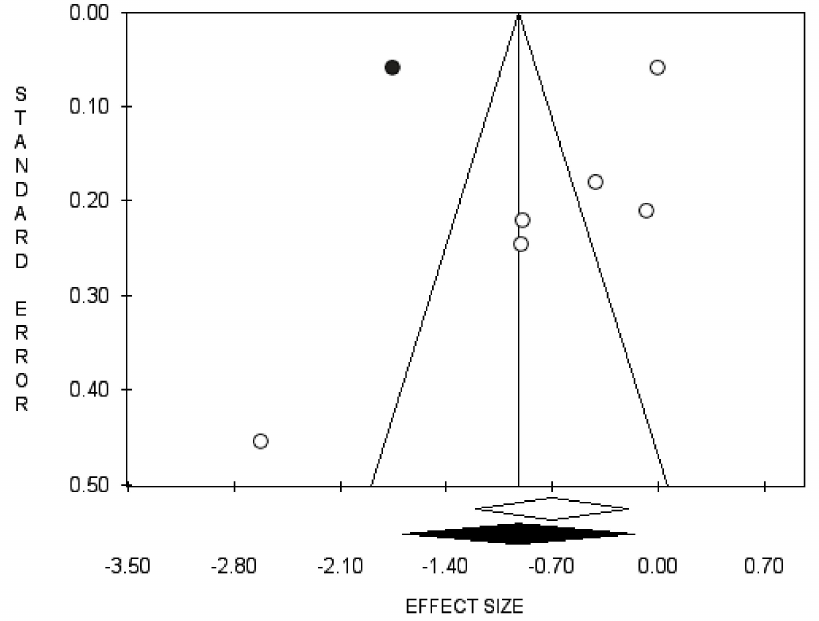
Figure 7. Funnel plots of the meta-analysis evaluating the association between use of 5-ARIs or ADT and the RR of BCa recurrence. Egger’s linear regression (t = − 3.84, p = 0.019) and Begg and